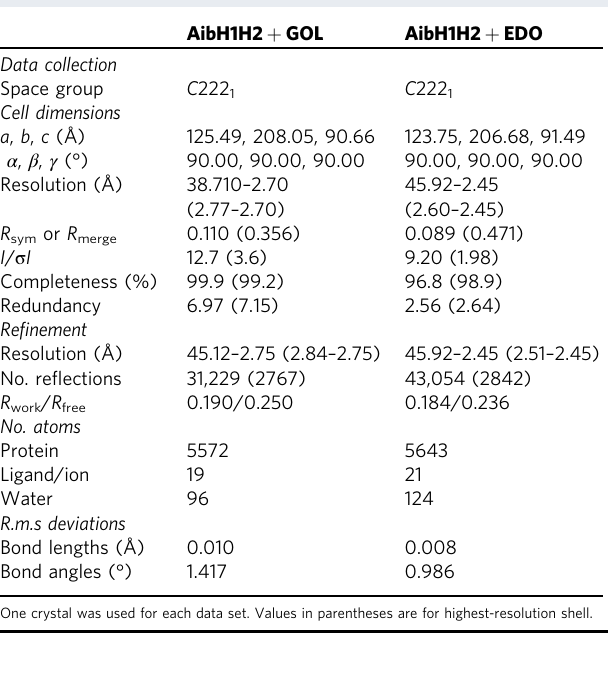
Table 2 Data collection and re fi nement statistics.